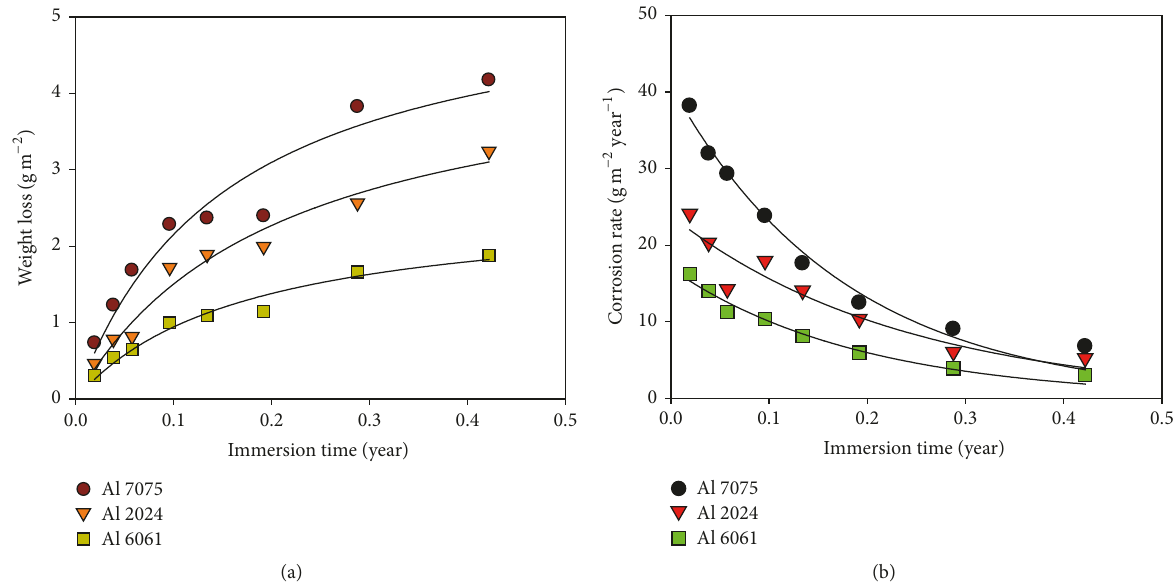
Figure 2: Dependence of weight loss and corrosion rates of Al alloys in the Red Sea water on immersion time.